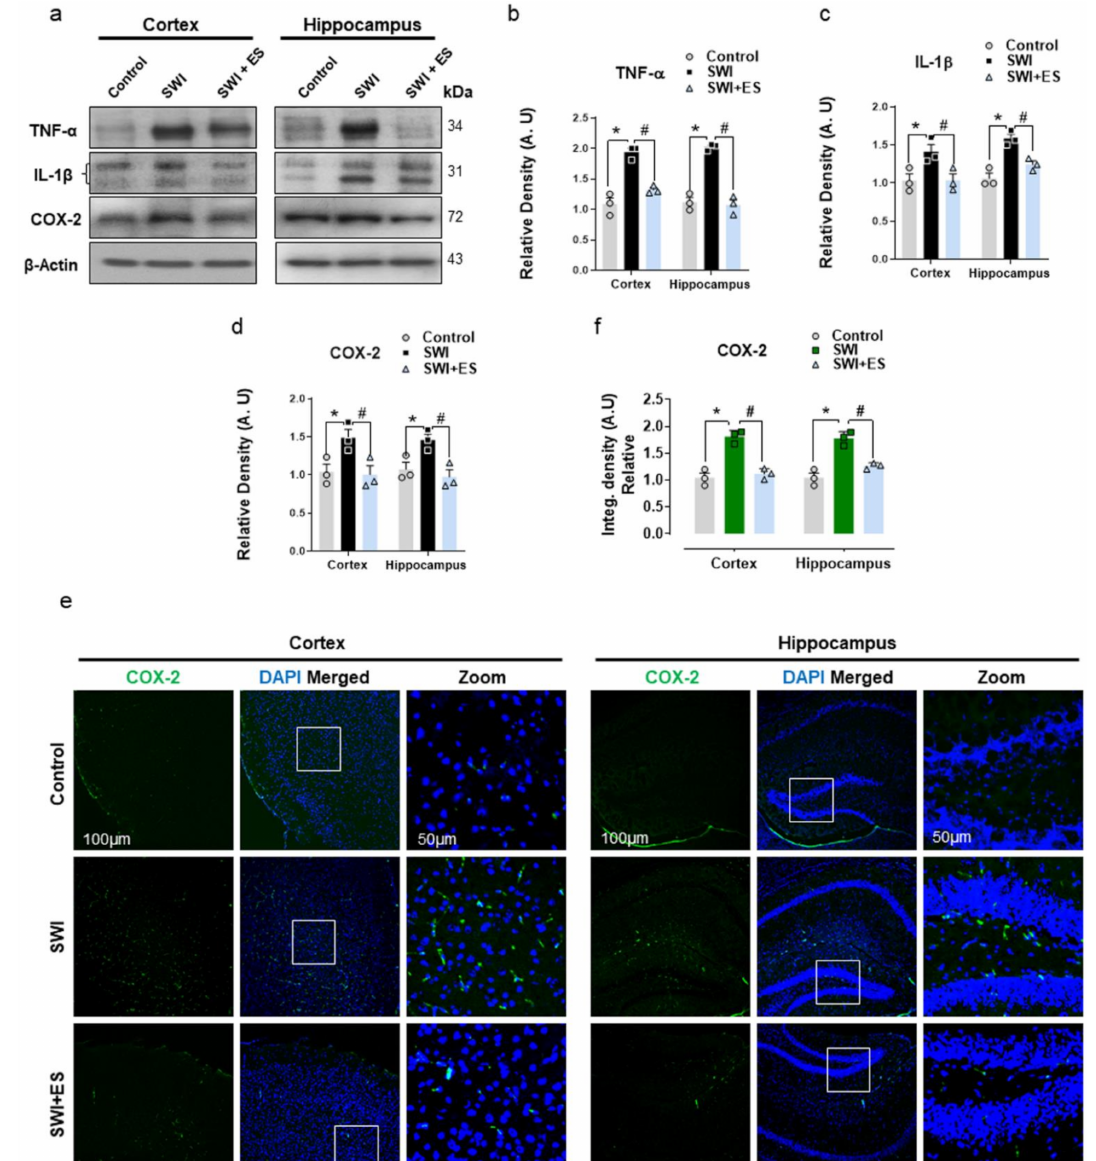
Figure 3. 17- β estradiol (ES) inhibits neuroinflammatory mediators after SWI. ( a – d ) Western blot analysis showing protein expression of Tnf- α , IL-1 β , and COX-2 in the experimental groups. Anti- β -actin was used as a control for protein levels across the samples. ( e , f ) Representative of COX-2 (green) immunoreactivity stained with DAPI (blue) in the cortex and DG region, with the respective histogram. The densities are expressed in arbitrary units (AU). Values are presented as means ± S.E.M. The data presented are relative to the control group. p -value < 0.05 was considered significant. * p < 0.05 vs. control group, # p < 0.05 vs. SWI + 17- β estradiol group. Bar = 50 µ m. Statistical significance was determined by one-way analysis of variance (ANOVA) followed by Tukey’s post-hoc analysis using the GraphPad Prism (ver. 8.0.2)